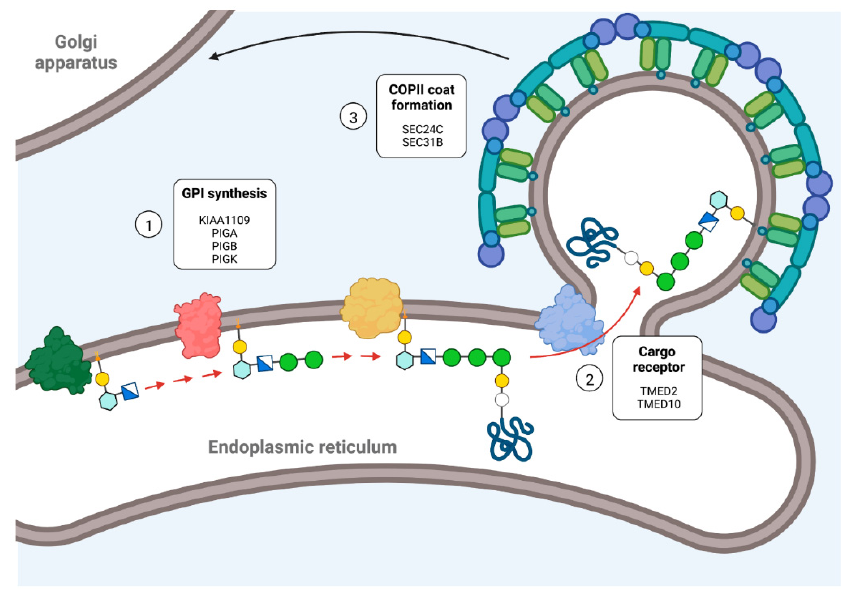
Figure 3. Deficiency in GPI biosynthesis and GPI-anchored protein trafficking causes iron accumu- lation in neurons. CRISPRi of genes encoding GPI biosynthetic enzymes (1), ER-associated cargo receptors for GPI-anchored proteins (2), and components of the COPII-coated vesicles involved in ER-to-Golgi GPI-anchored protein trafficking (3) results in iron accumulation in neurons. Newly synthesized GPI-anchored proteins interact with the cargo receptors TMED2 and TMED10 [51] and are selectively packed in COPII-covered vesicles (specifically com- posed by SEC24C and SEC24D) for ER-to-Golgi trafficking [52]. Interestingly,